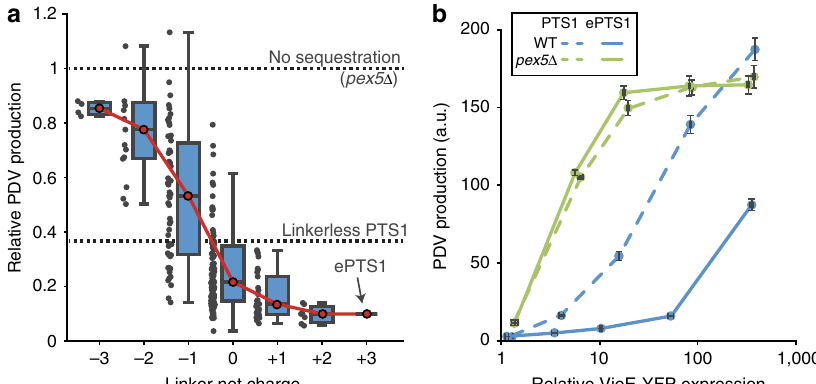
Figure 2 | Library screening indicates that positively charged linker residues enhance PTS1-based import of VioE. ( a ) A randomized library of six amino-acid linkers was inserted between VioE-YFP and the PTS1 tag and coexpressed with cytosolically localized VioA and VioB. Individual data points represent PDV-linked fluorescence measurements of two hundred arbitrarily selected library members (excluding two outliers with values 1.45 and 1.73 at the (cid:2) 2 charge level for clarity), normalized relative to a pex5 D strain and grouped by net charge of the linker residues. Quartiles and extrema for each net charge level are shown with a box-and-whiskers plot. The median PDV productivity at each net charge is further highlighted with a red line. Efficient peroxisomal import of VioE is correlated with decreased PDV production. We selected the sole þ 3 charge sequence, LGRGRR-SKL, for further study as ePTS1. ( b ) HPLC quantification of PDV from yeast strains expressing increasing levels of VioE-YFP fused to either naı¨ve PTS1 (dashed lines) or ePTS1 (solid lines). Both wild-type (blue lines) and pex5 D (green lines) strain backgrounds coexpressed VioA and VioB cytosolically. Error bars represent the mean ± s.d. of four biological